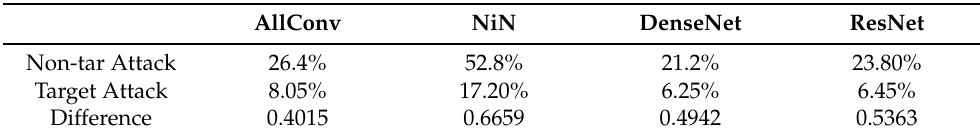
Table 2. Success rate, including target attack and non-target attack, and confidence difference of one-pixel attacks. AllConv: all convolution network. NiN: Network in Network. Non-tar